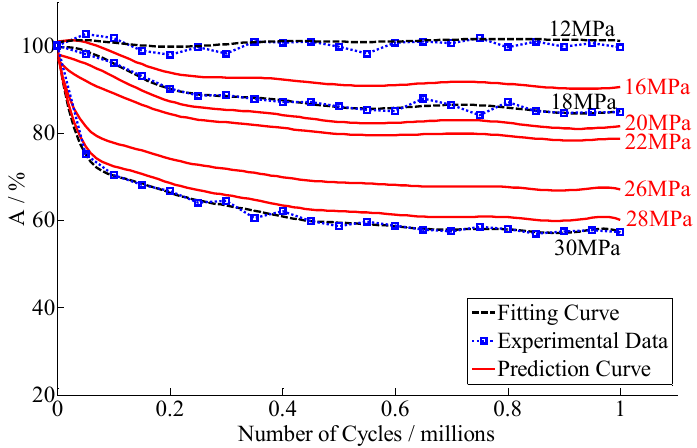
Figure 11. Predicted actuation function degradation curves (red solid line) of the MFC actuator undergoing cyclic load with stress amplitudes of 16 MPa, 20 MPa, 22 MPa 26 MPa and 28 MPa.